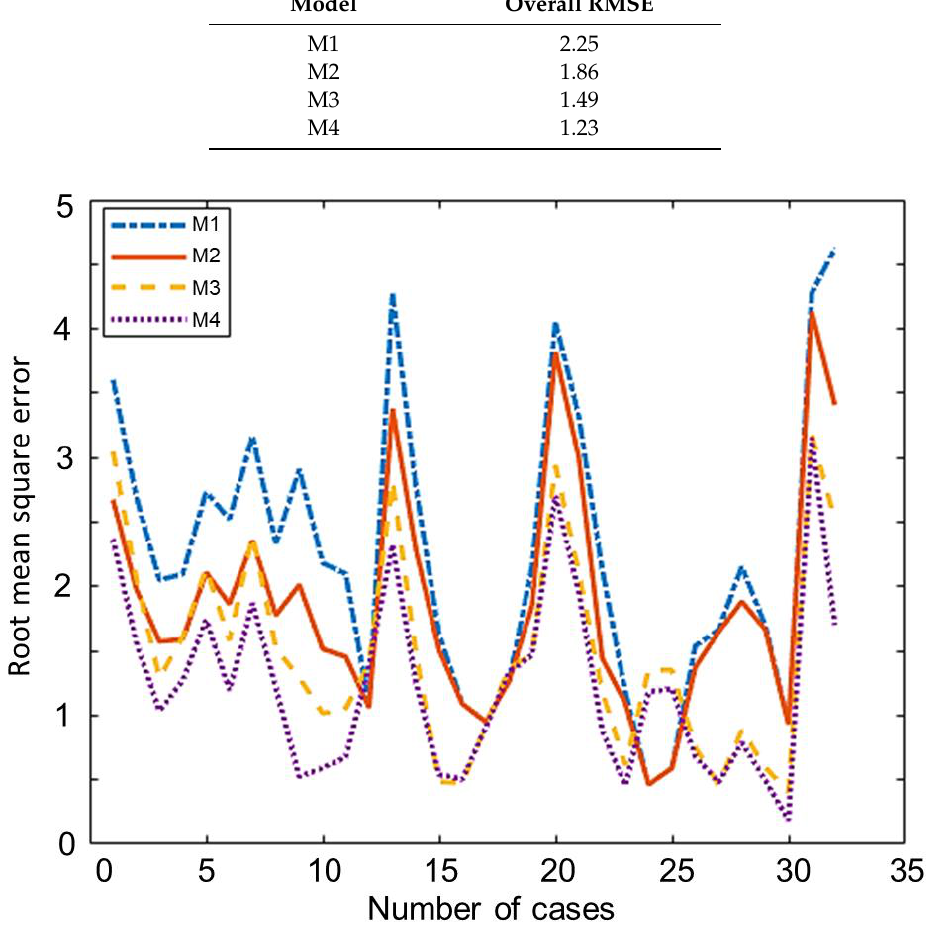
Table 7. The overall room mean square error (RMSE) of all four models based on the training data set. Model